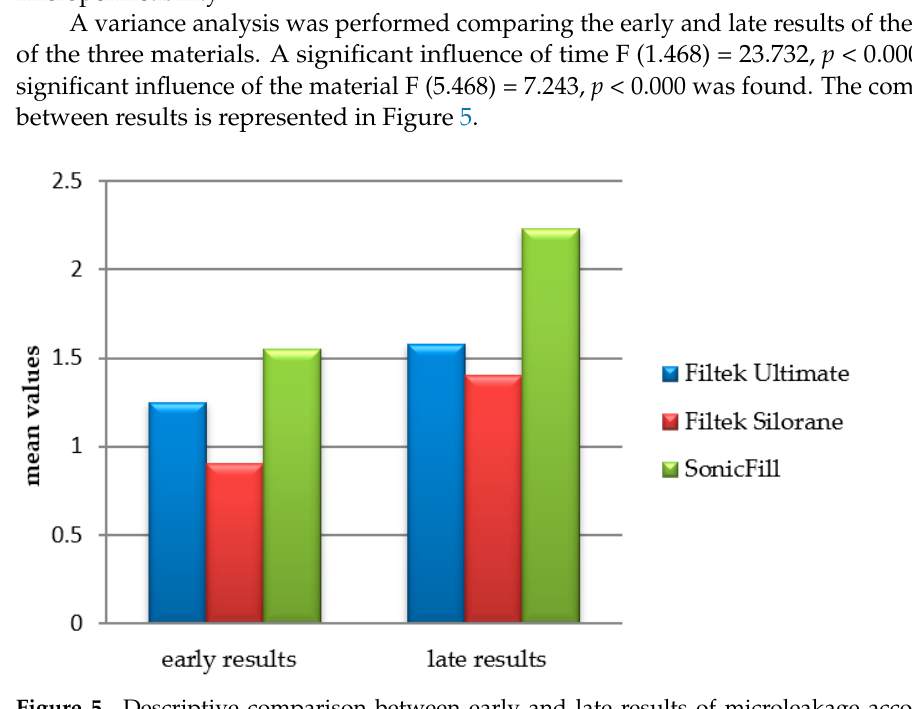
Figure 5. Descriptive comparison between early and late results of microleakage according to mean values.